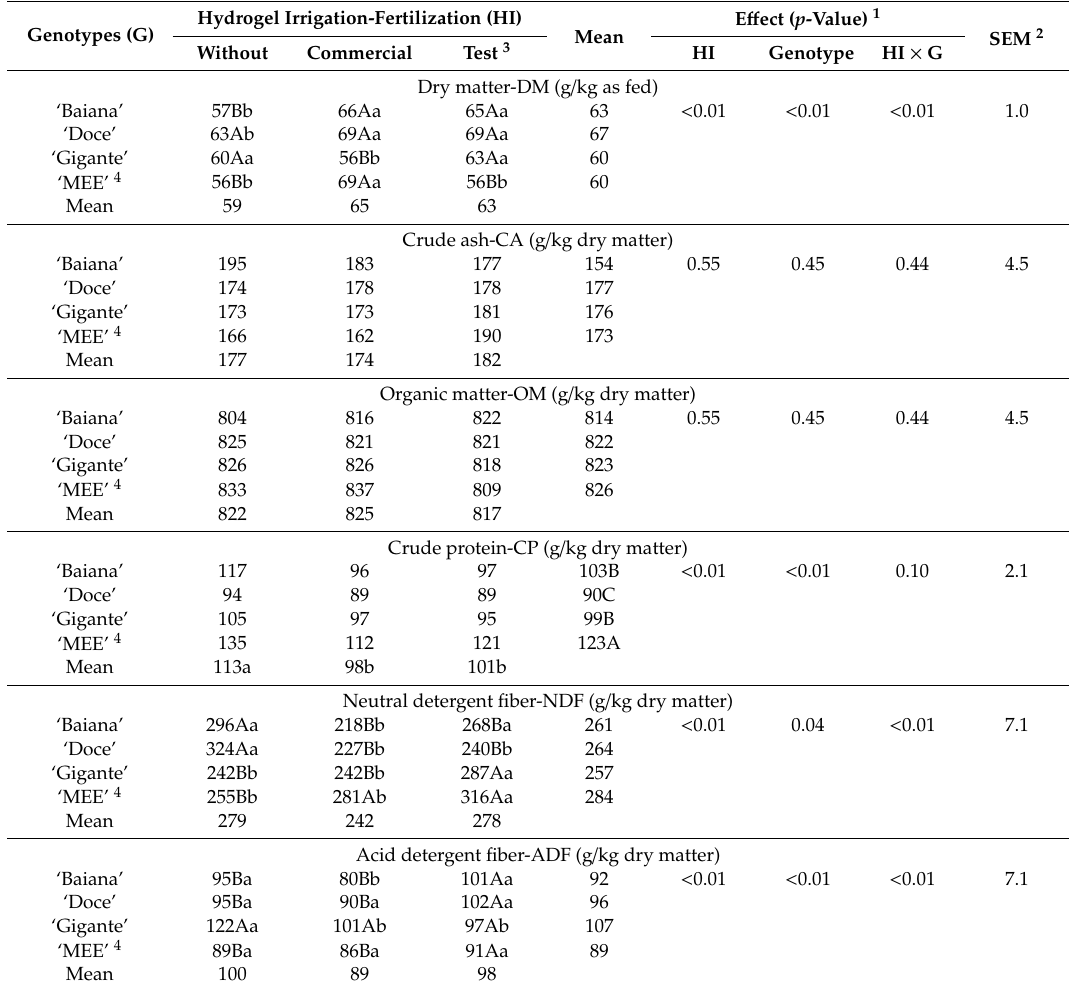
Table 3. Chemical composition of four cactus pear genotypes under di ff erent irrigation-fertilization